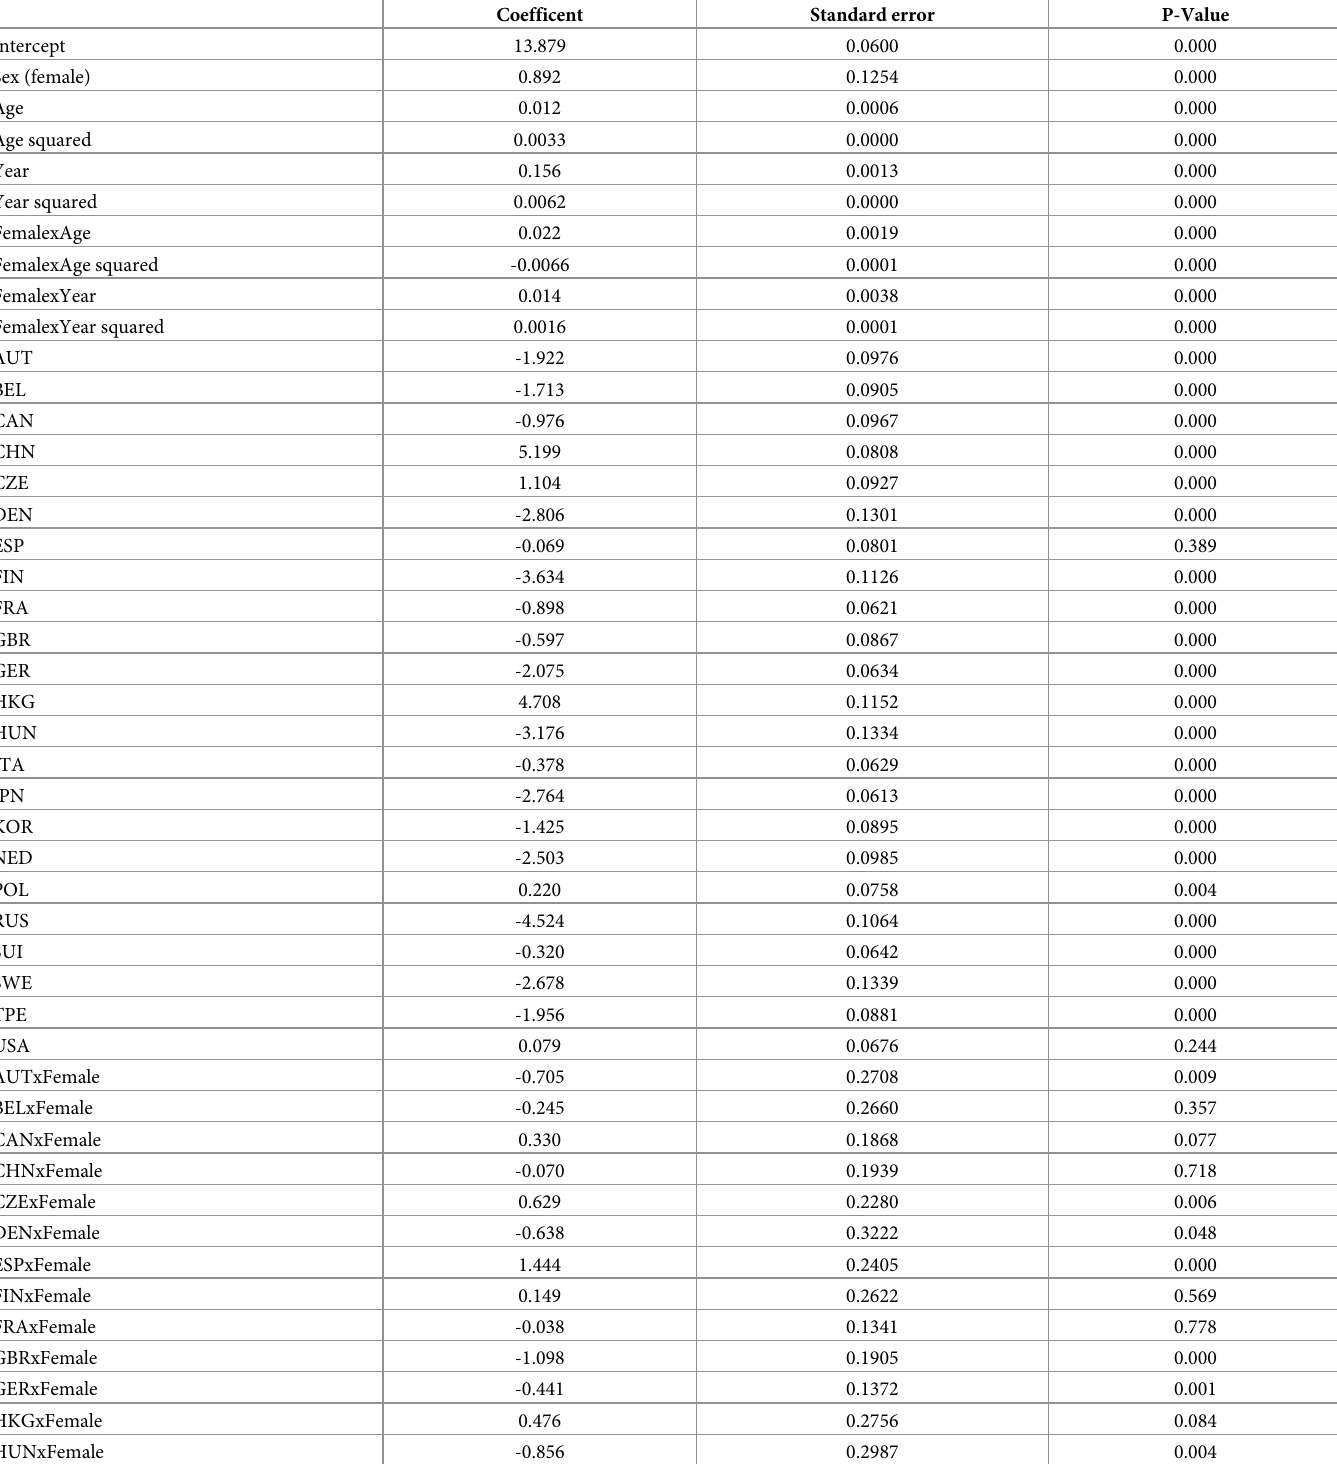
Table 10. Results from linear regression with complete dataset time = sex × (year+year 2 )+sex × (age+age 2 )+sex × nationality and referenced to male, age 44, year 2009 and nationality Australia. R 2 =